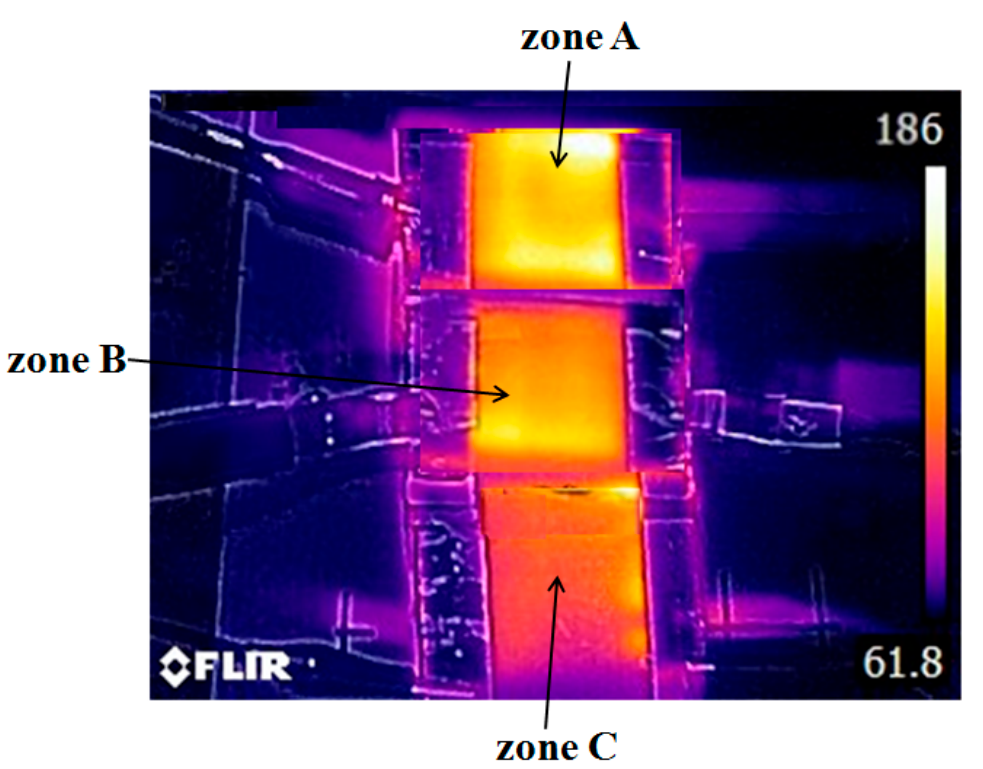
Figure 7. Temperature distribution of the graphene-based heater when input voltages of 30, 25, and 20 V were applied to zones A, B, and C, respectively. (The average steady-state temperatures of zones A, B, and C were 180 ± 3 °C, 145 ± 3 °C, and 116 ± 4 °C, respectively.)